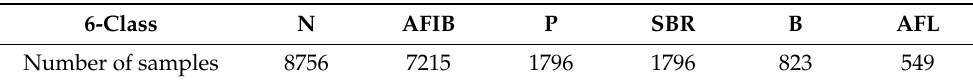
Table 2. Number of samples in the 6-class dataset difficult to distinguish ECG rhythms with similar characteristics, such as AFIB and AFL. Abbreviations are defined in the text.